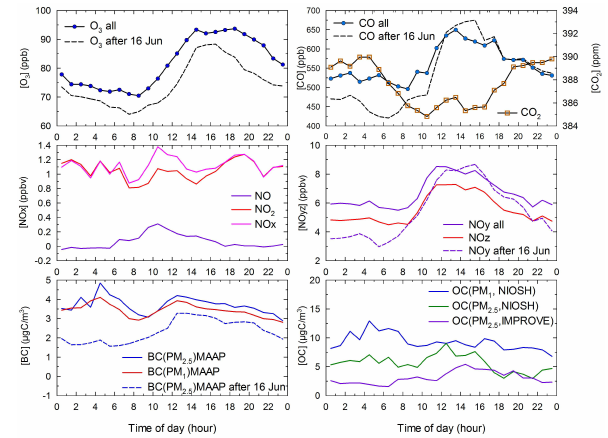
Fig. 6. Average diurnal variations in O 3 , CO, CO 2 , NO, NO 2 , NO x , NO y , NO z , BC, and OC concentrations during the whole MTX2006 campaign period (solid lines). Dashed lines are for the latter half period after 16